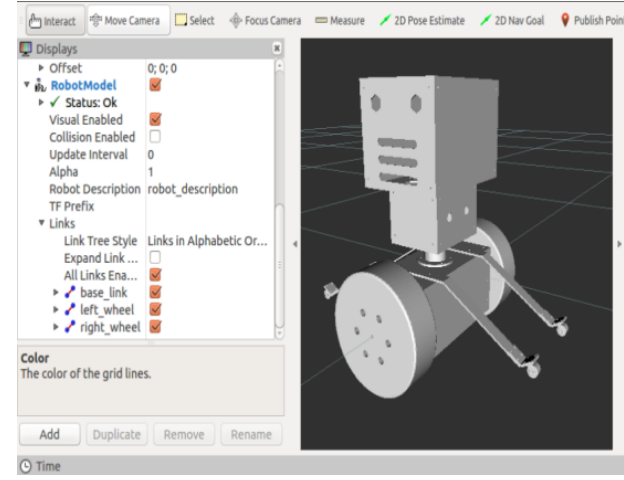
Figure 17. Inspection robot URDF model.